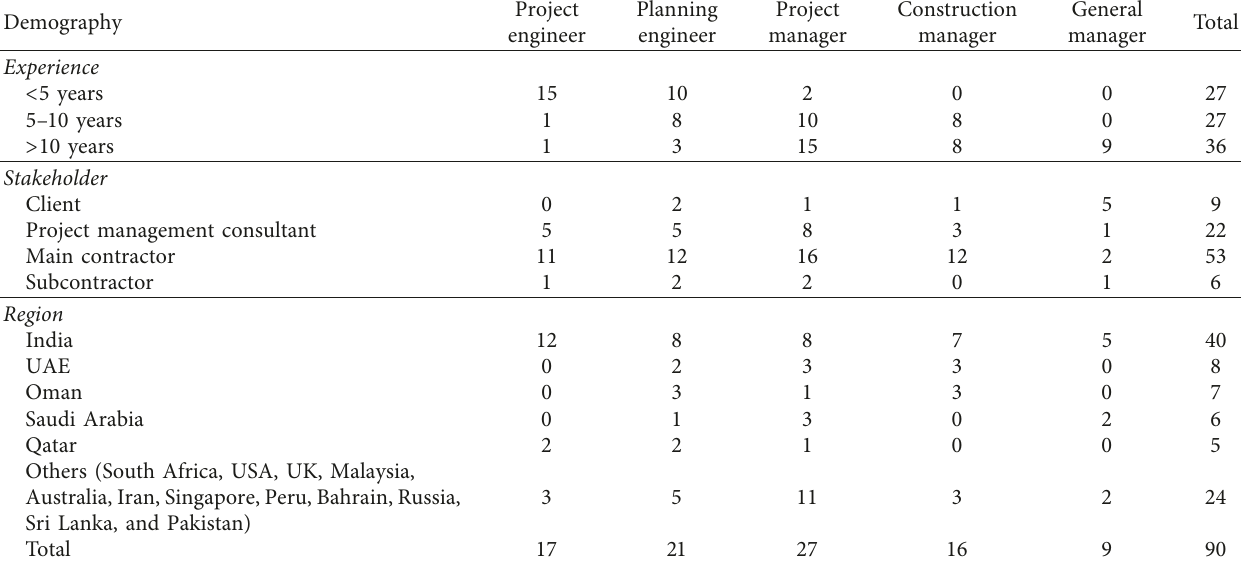
Table 2: Demographics of